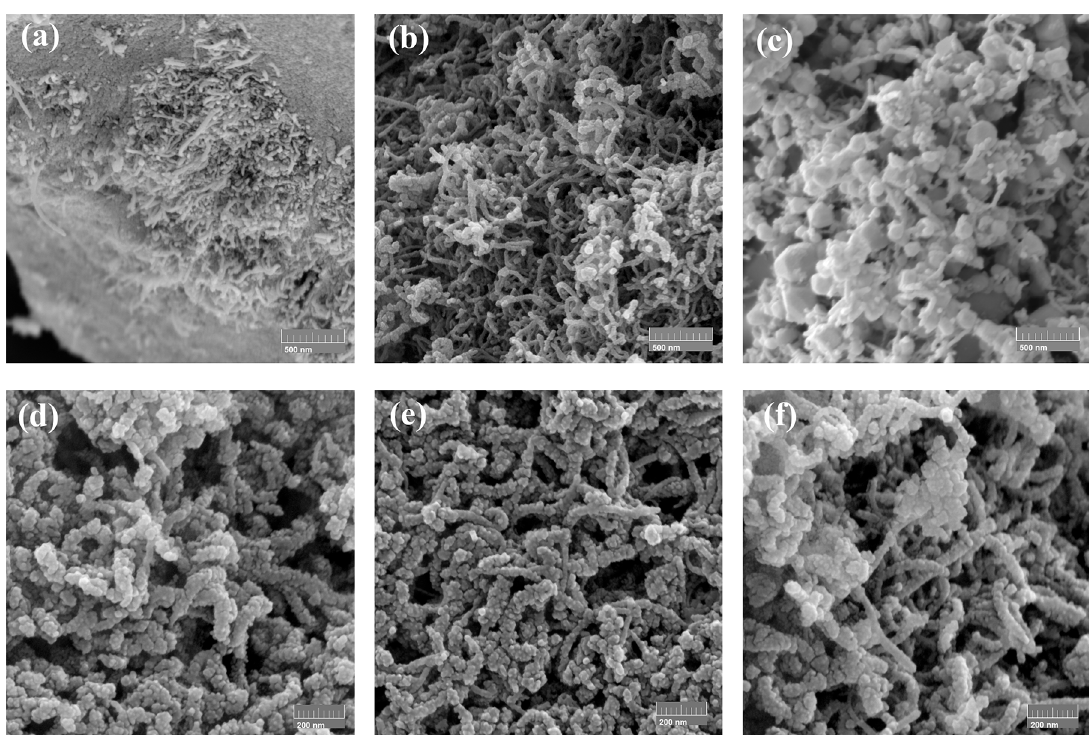
coated MWCNT obtained using 28 %wt. of MWCNT and a TTIP:H Figure 4. TiO 2 Coatings obtained with a fixed molar ratio of 1:220 with different MWCNTs to TiO higher magnification of (b) is shown, for comparison purpose.